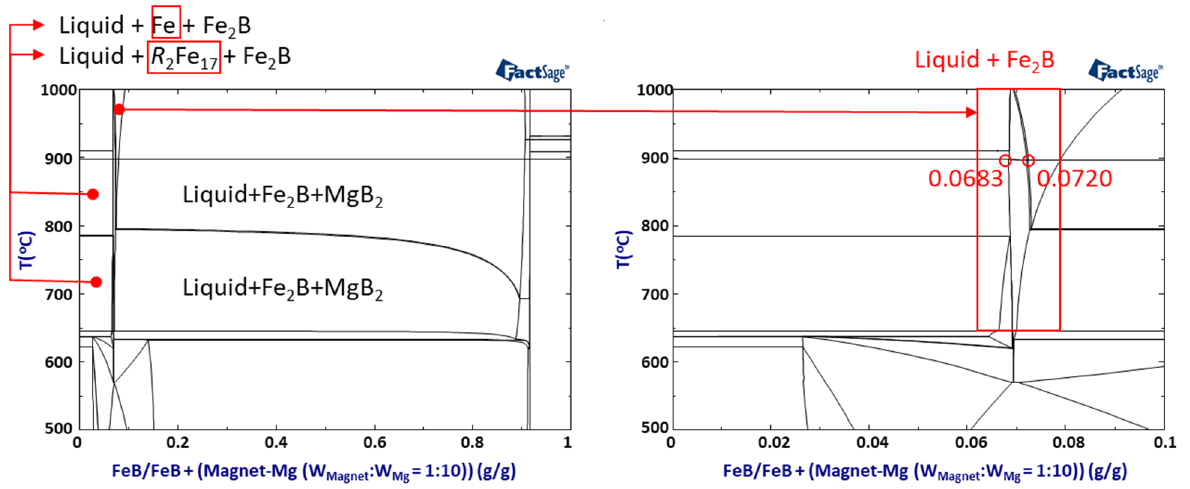
Figure 6. Thermodynamic calculation of Mg–FeB–magnet with an optimized weight ratio between the magnet and Mg as 1:10 (W Magnet :W Mg ).